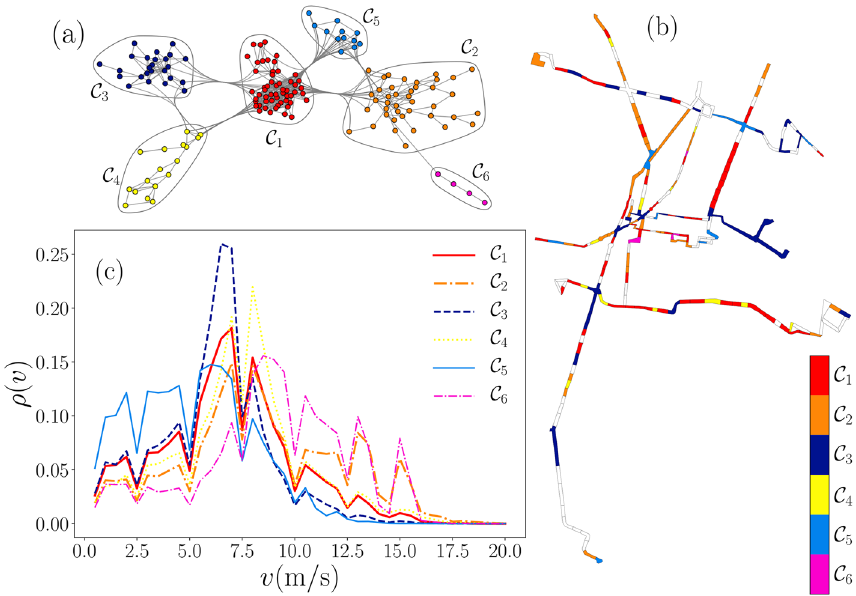
Figure 7. Segment classification through similarity networks with H = 0.05 . ( a ) Largest connected component for a similarity network with communities C l ( l = 1, 2, . . . , 6 ) represented with different colors. ( b ) Segments map with the representation of communities. ( b ) Probability densities ρ( v ) for all the values in the segments in each community. The network in panel ( a ) was generated using Mathematica 12.3.1 (https:// www. wolfr am. com/ mathe matica/). Figures ( b )–( c ) were created using python 3.8 and the matplotlib (3.4.3) package (https:// matpl otlib. org). The map in panel ( b ) was created using the geopandas (0.10.2) package (https:// geopa ndas.